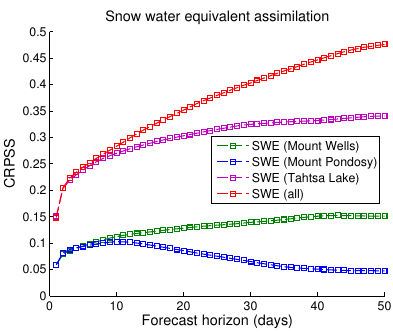
Figure 10. Continuous rank probability skill score of the stream- flow ensemble when assimilating SWE from all three snow pillow locations. The open loop is used as a reference. The forecast horizon varies from 1 to 50 days.